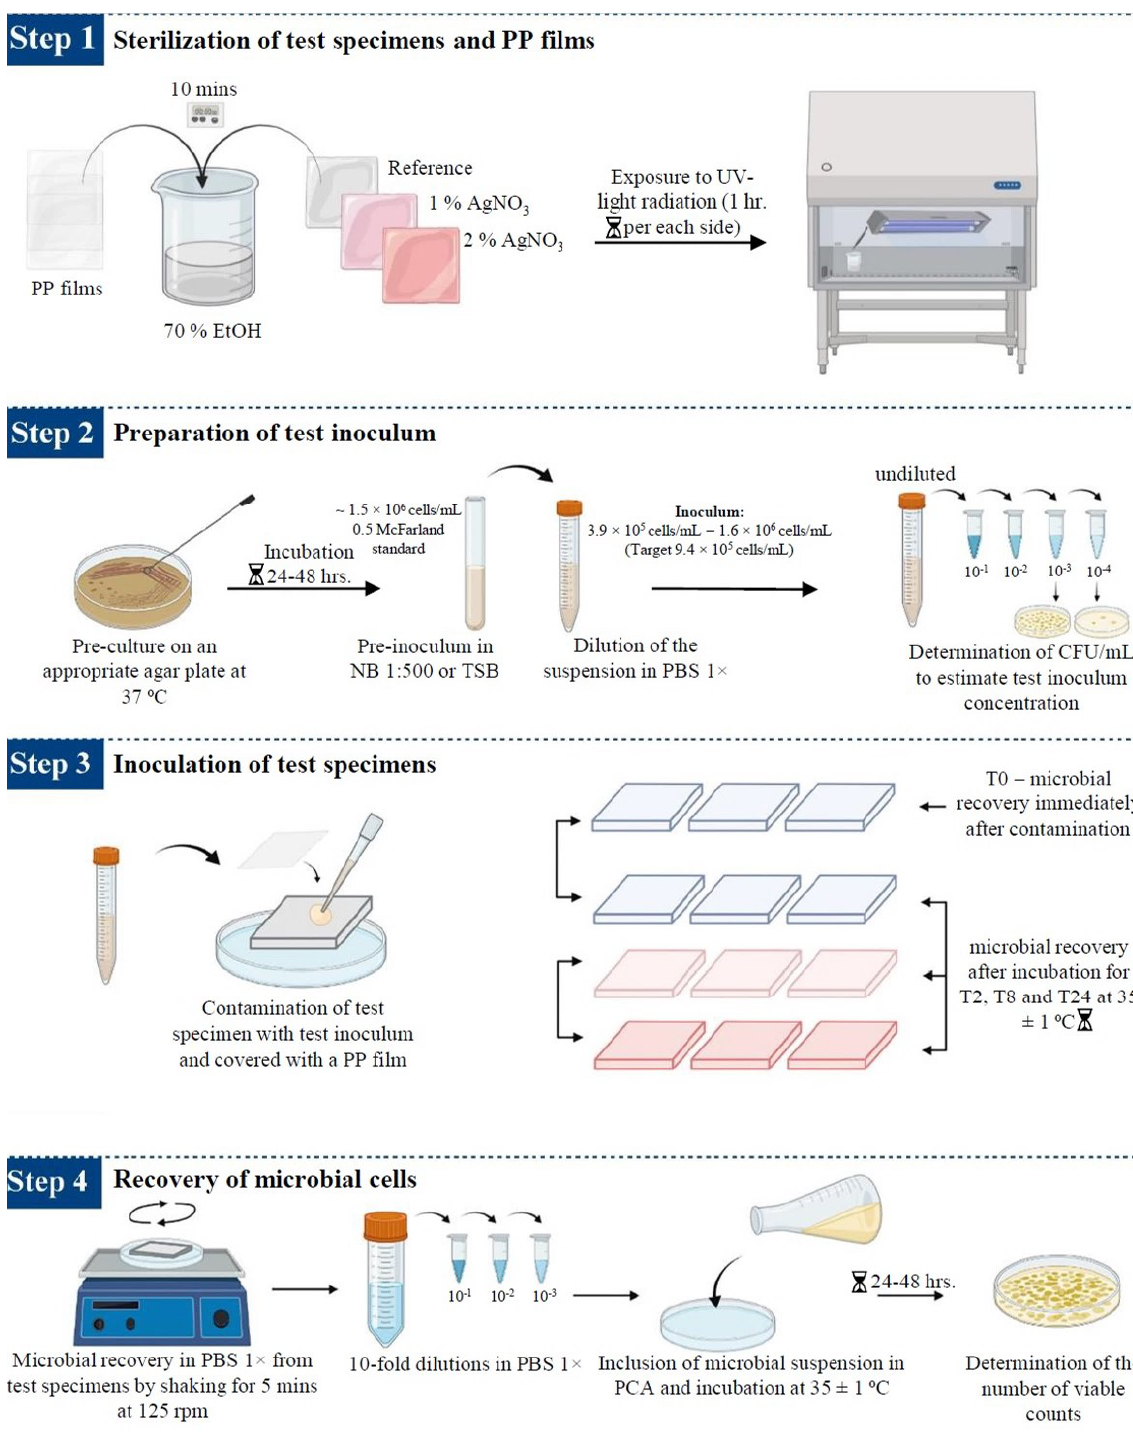
Figure 12. Schematic representation of the procedure used to determine the antimicrobial activity of the enameled surfaces. The image was taken and modified from